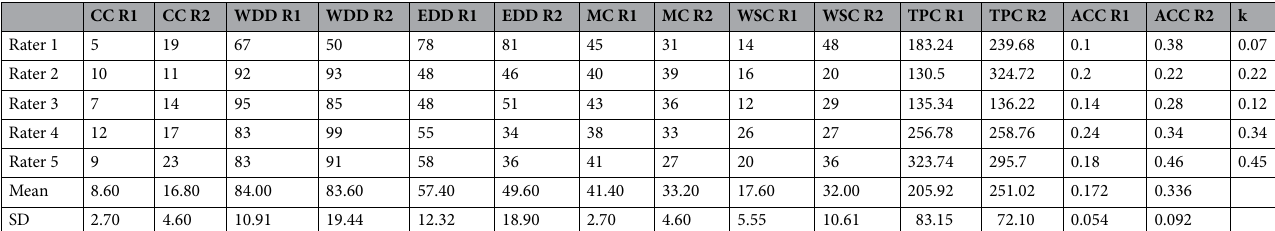
Table 2. List of the results of the evaluation of the 5 readers (CC = R1 Correct cases (round 1); CC R2 = Correct cases (round 2); WDD R1 = Wrong differential diagnoses (round 1); WDD R2 = Wrong differential diagnoses (round 2); EDD R1 = Empty differential diagnoses (round 1); EDD R2 = Empty differential diagnoses (round 2); MC R1 = Missed cases (round 1); MC R2 = Missed cases (round 1); WSC R1 = Weighted score (round 1); WSC R2 = Weighted score (round 2); TPC R1 = Time per case (round 1); TPC R2 = Time per case (round 2); ACC R1 = Accuracy (round 1); ACC R2 = Accuracy (round 2); k = Intra-rater agreement (Cohen’s